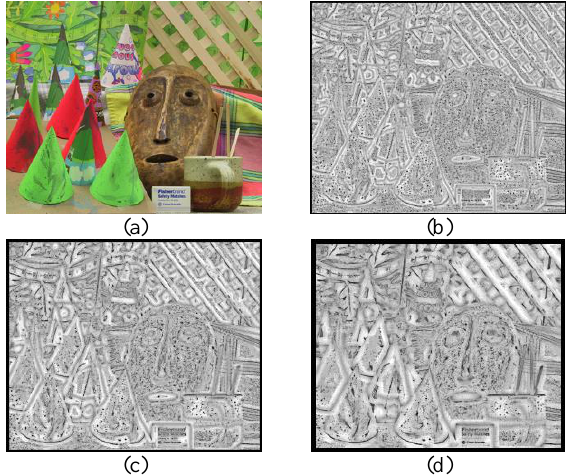
Figure 2. Surrounding information of Cones. (a) Original left